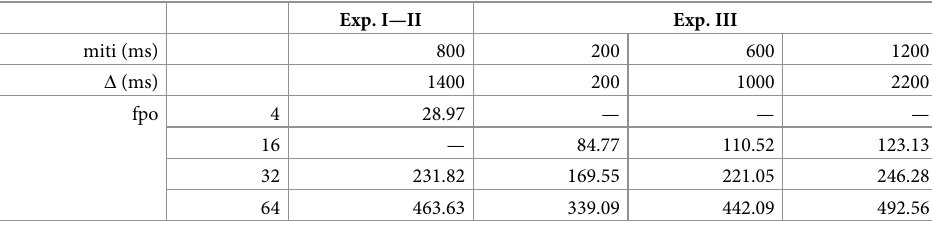
Table 2. Masker uncertainty quantified by entropy (in nats) of the tone